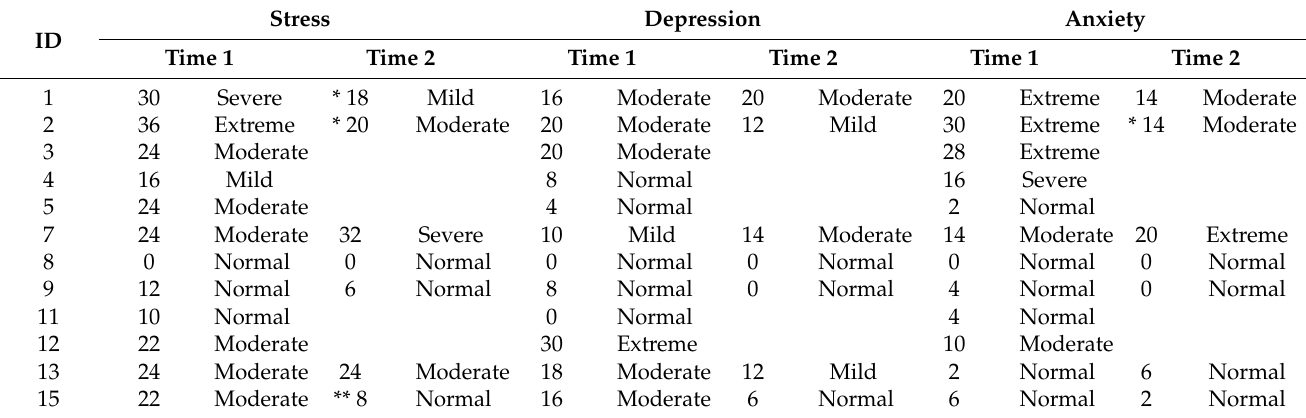
Table 12. DASS-21 measured depression, anxiety, and stress at pre- and post-study.